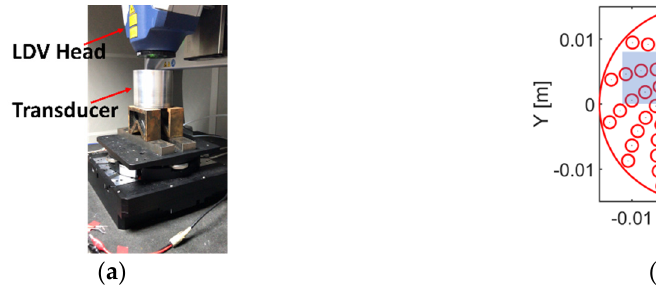
Figure 7. ( a ) Illustration of the experimental setup for mechanical cross-talk measurement. ( b ) Illustration of how the LDV scanning was processed. The black circle represents the fired array element. The blue block represents the area that was scanned.